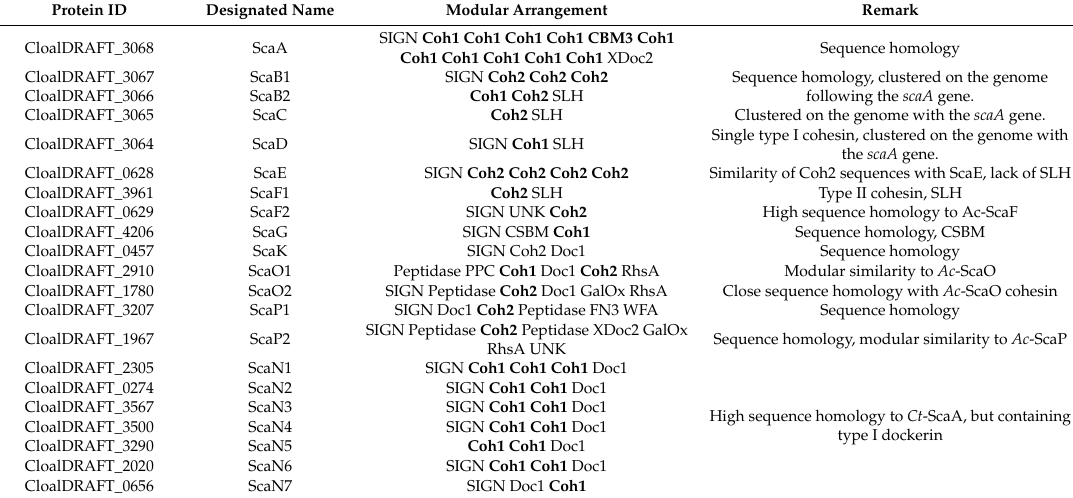
Table 1. Putative cohesin-borne sca ff olding protein of C. alkalicellulosi . The type I and type II cohesins ( Coh1 and Coh2 ) are shown in bold font in the table, since the cohesin module is the definitive sca ff oldin